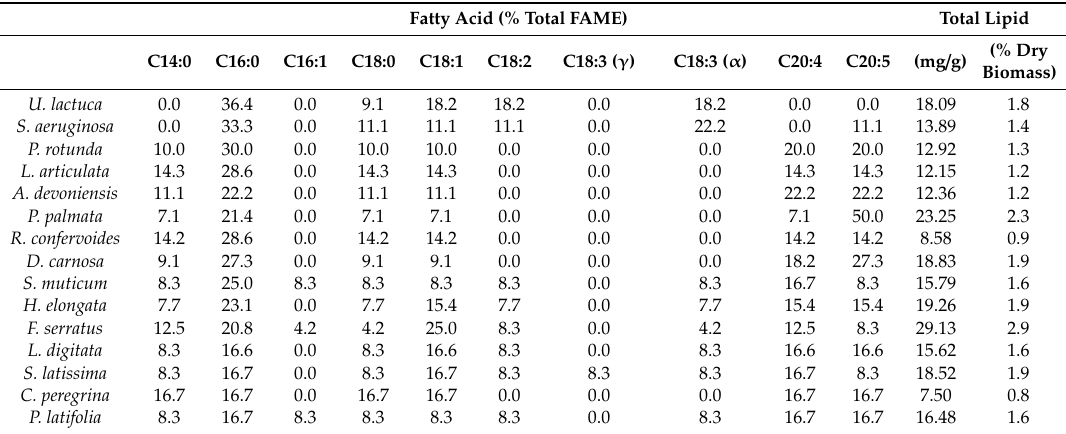
Table 2. Fatty acid (FA) profiles of South West seaweed samples. Data, expressed as % of total FA content and total lipid, are given as mg / g and % of dry